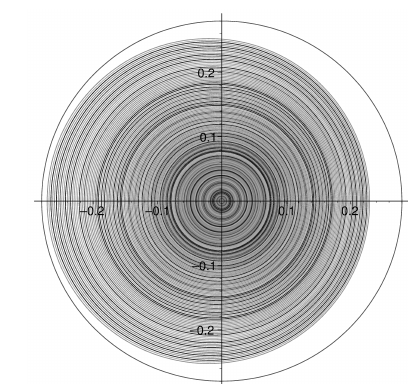
(a) Functions G 1 .z/ D 1 (cid:0) sin z z and G 2 .z/ D 0:18z (b) Functions H 1 .z/ D sin 2 z 2 and H 2 .z/ D